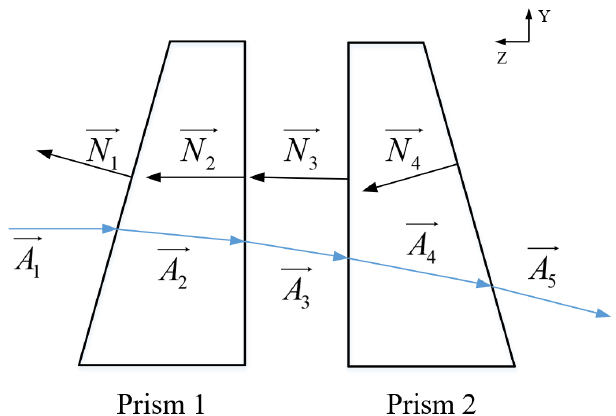
Figure 3. Diagrams illustrating the notation of the normal vector for each prism and the incident ray vector. The black arrows represent the surface normal vectors, and the blue arrows represent the incident and refracted light vectors.